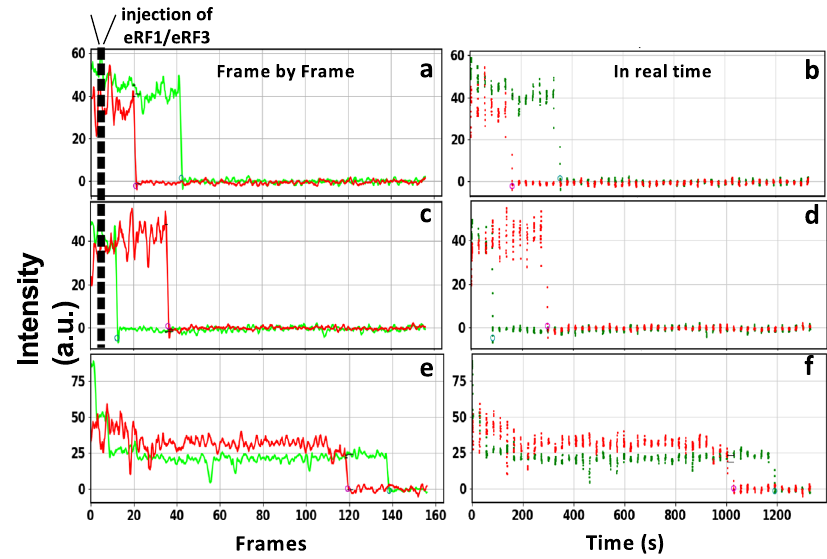
Fig. 3 Typical traces showing the dissociation of Atto-647 labeled peptide (red) and Cy3-labeled tRNA (green) following eRF1/eRF3 injection. In the time-lapse experiment the sample was brie fl y illuminated between fi xed time intervals. Sample traces following eRF1/eRF3 injection. In a the peptide signal disappears prior to tRNA signal; in ( c ) the tRNA signal disappears prior to peptide signal. b and d Corresponding real-time scatter plots of the traces presented in ( a ) and ( c ) where each dot represents one frame. e Sample trace from a control experiment where only buffer was injected to obtain the photobleaching/spontaneous dissociation rate, which is clearly much slower than the rates seen in ( a ) and ( c ). f The real-time scatter plot of the trace presented in ( e ). Source data for ( a ), ( c ), and ( e ) are provided as a Source Data fi